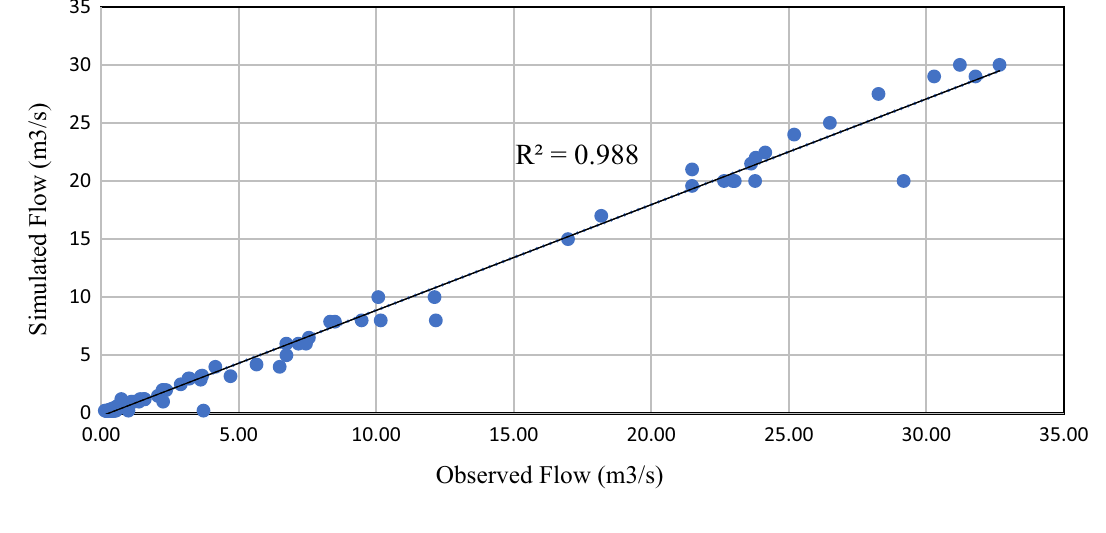
Fig. 14 Validation scatter plot of observed vs. simulated flow (2005–2012) Fig. 15 Mean monthly flow contrast a calibration and b validation years